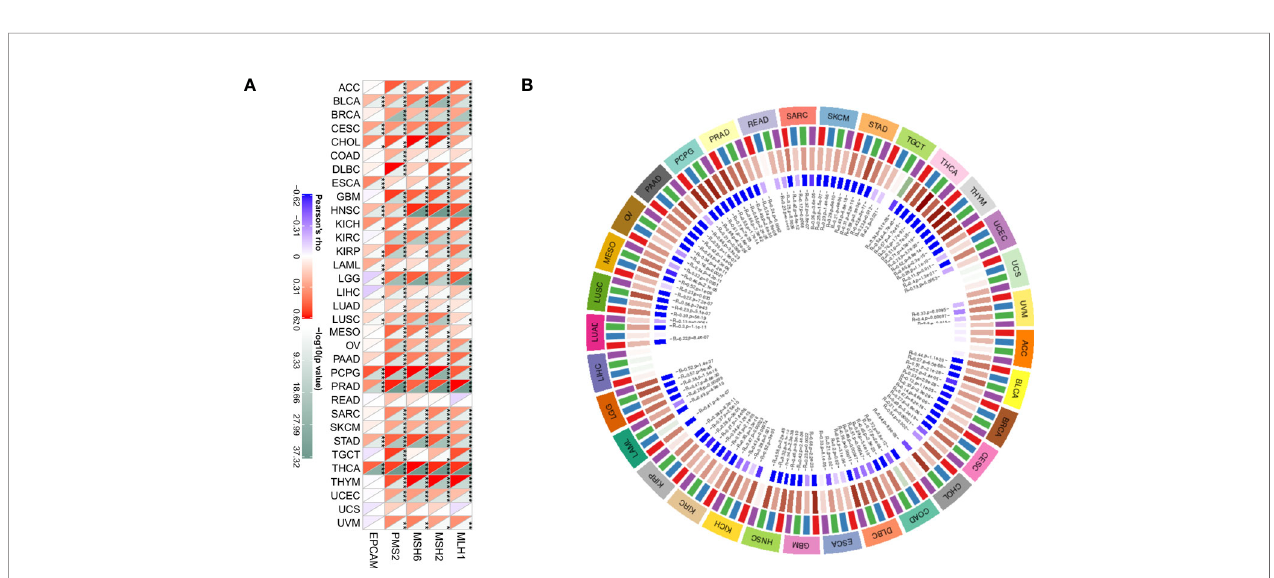
FIGURE 10 | Correlation of HDAC6 expression level with MMR gene and methyltransferase. (A) Spearman test to analyze the correlation between HDAC6 expression level and MMR gene in various tumors. (B) Spearman test to analyze the correlation between HDAC6 expression level and methyltransferase in various tumors. * Indicates that EPCAM, PMS2, MSH6, MSH2, MLH1 and HDAC6 are correlated in tumors, P<0.05. **Indicating that EPCAM, PMS2, MSH6, MSH2, MLH1 and HDAC6 are correlated in tumors, P< 0.01. *** means EPCAM, PMS2, MSH6, MSH2, MLH1 and HDAC6 are correlated in tumors,